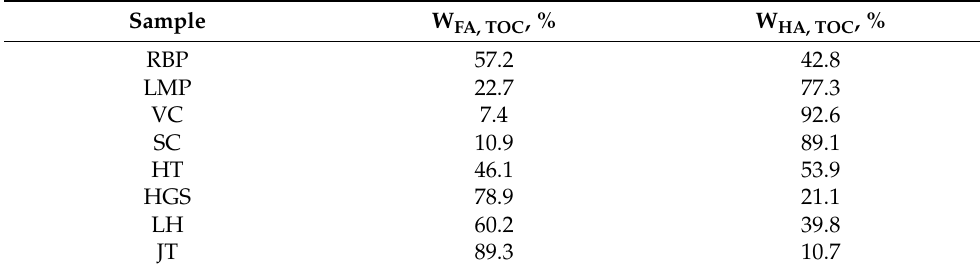
Table 3. Minor and trace elements in the studied humic matter samples ( µ g g − 1 ). (See Table 1 for sample name abbreviation definitions.)